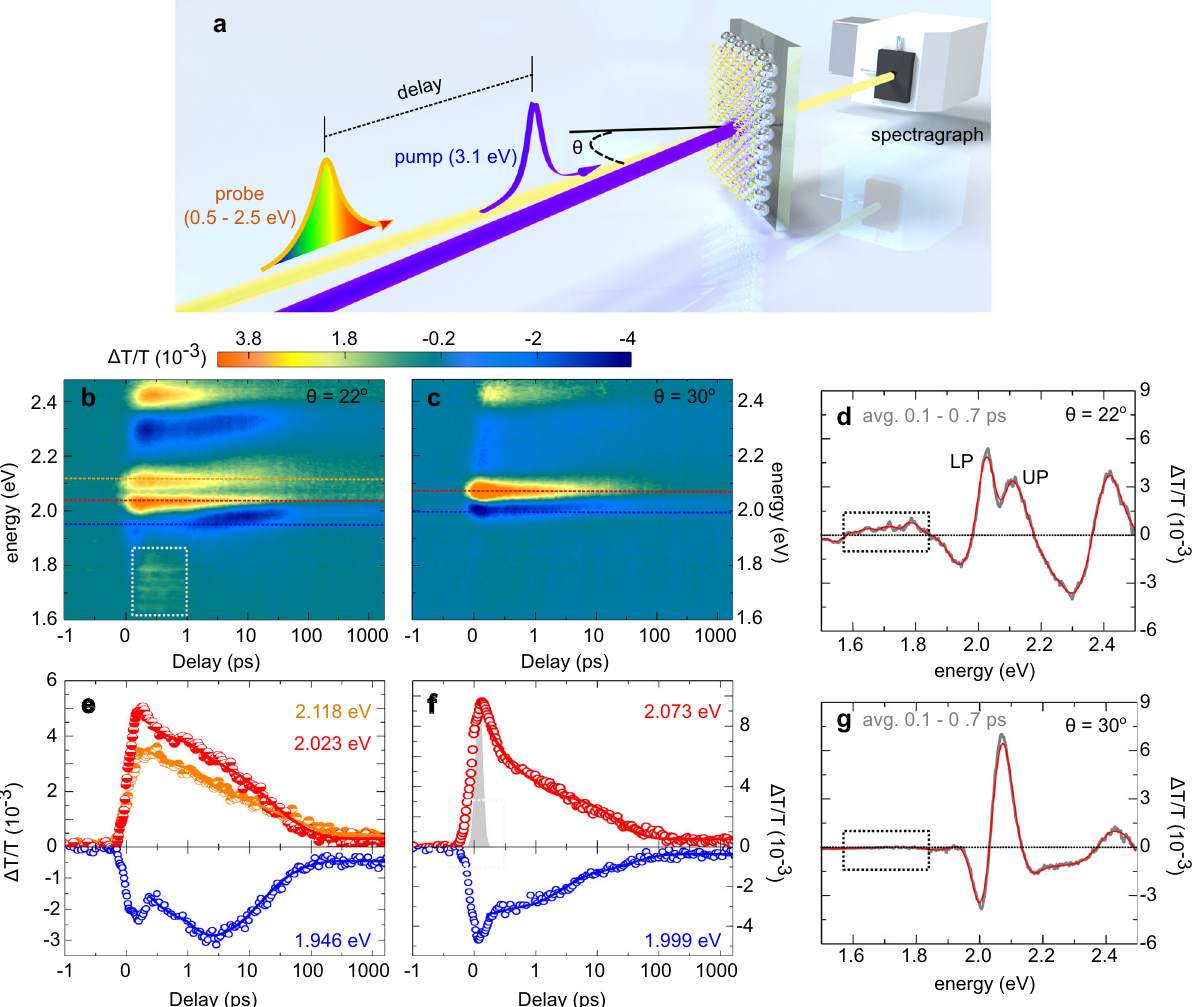
Fig. 2 Transient optical responses of PC-WS 2 systems. a Schematic of angle-resolved ultrafast pump-probe spectroscopy; (note: the pump and probe beams are nearly colinear in practical experiments) b , d , e Refer to normalised differential transmission spectra ( Δ T / T ) at the tuned angle ( θ = 22°), while c , f , and g refer to Δ T / T at the detuned angle ( θ = 30 ∘ ). b , c Intensity plots of Δ T / T as function of time delay and probe photon energy, using the same colour bar (which is also used by Fig. 3a). d , g Δ T / T spectra averaged within the time span from 0.1 to 0.7 ps after pump. e , f Δ T / T transient at speci fi c energies (labelled with different colours), in which scatter symbols and solid curves represent measured and fi tted data, respectively. Dashed frames in panel b , d , g Mark the spectral region of the broad maxima (see main text). All measurements were carried out using 400 nm ( E = 3.1 eV) pump pulses that have 100 fs duration and pump fl uence of 12 μ J cm − 2 at room temperature. The instrument-response-function is shown as the grey area in f . All time axes are displayed in logarithmic